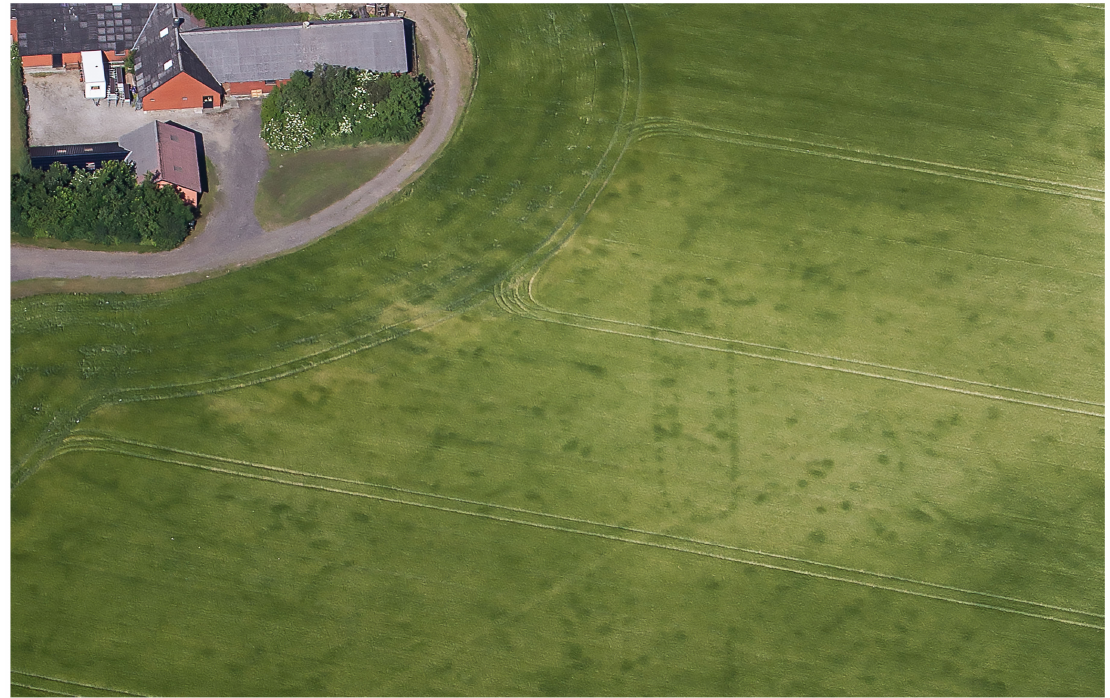
Figure 3. Positive cropmarks revealing a remarkably sized longhouse from the early Bronze Age located in Frihedsminde, Central Jutland, Denmark. It measures 40 by 8.5 m and covers no less than 320 square meters. Photo by Lis Helles Olesen, Holstebro